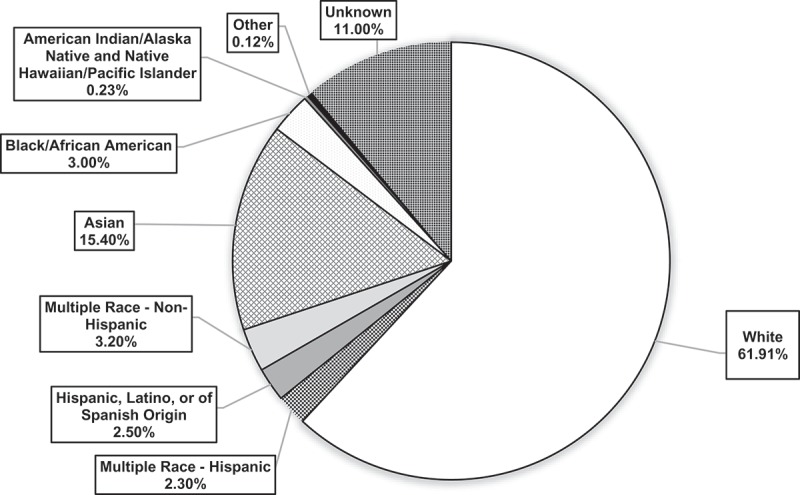
Race ethnicity breakdown in 2016 (N = 166,713).